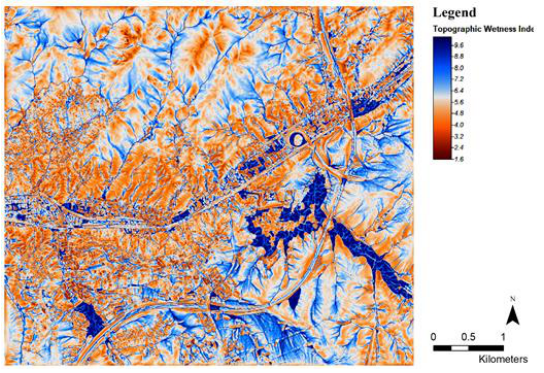
Figure 10. TWI map of the study area